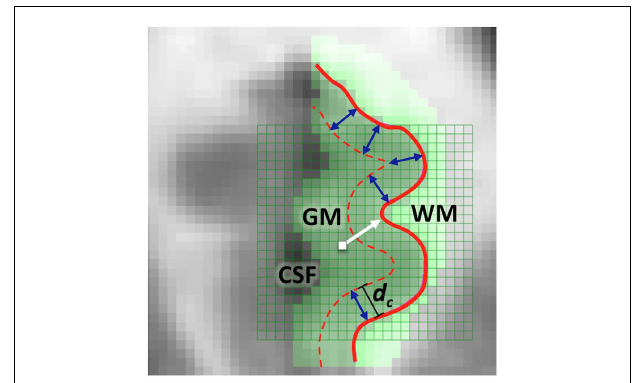
FIGURE 1 |A two-dimensional illustration of LCDM distance (i.e., the normal distance) from a GM voxel to the GM/WM surface (thick white arrow) and of the censoring procedure with censoring distance d c (blue double arrows) . At this censoring step, the GM voxels whose centroids closer to the GM/WM surface than d c are